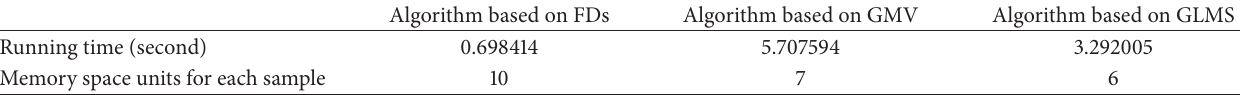
Table 4: Comparison of three types of